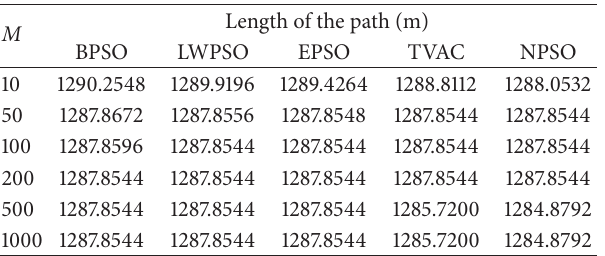
Table 4: Comparison between BPSO, LWPSO, EPSO, TVAC, and NPSO for UUV path planning.